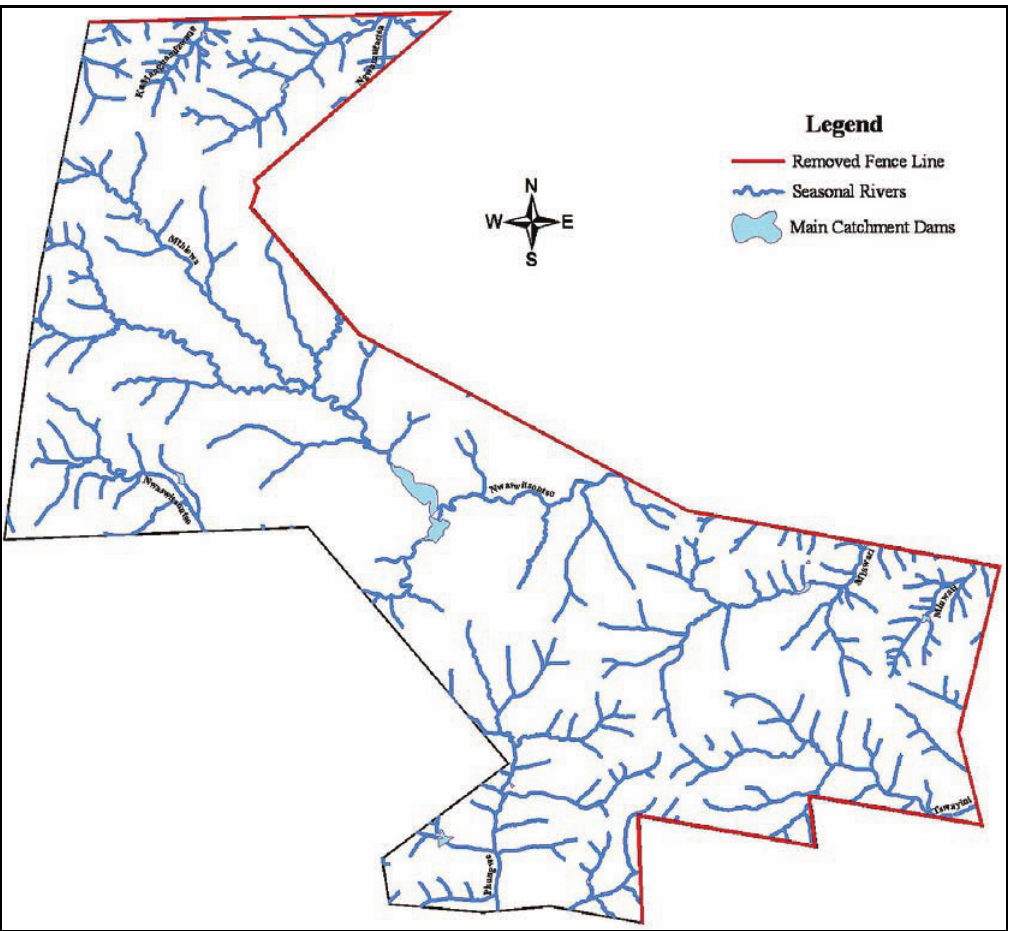
Fig. 3. The seven seasonal rivers that traverse the Manyeleti Game